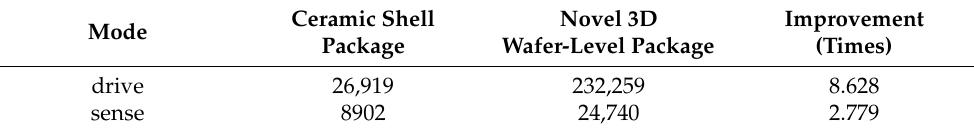
Table 3. Q-factor comparison between ceramic shell package and 3D wafer-level package.